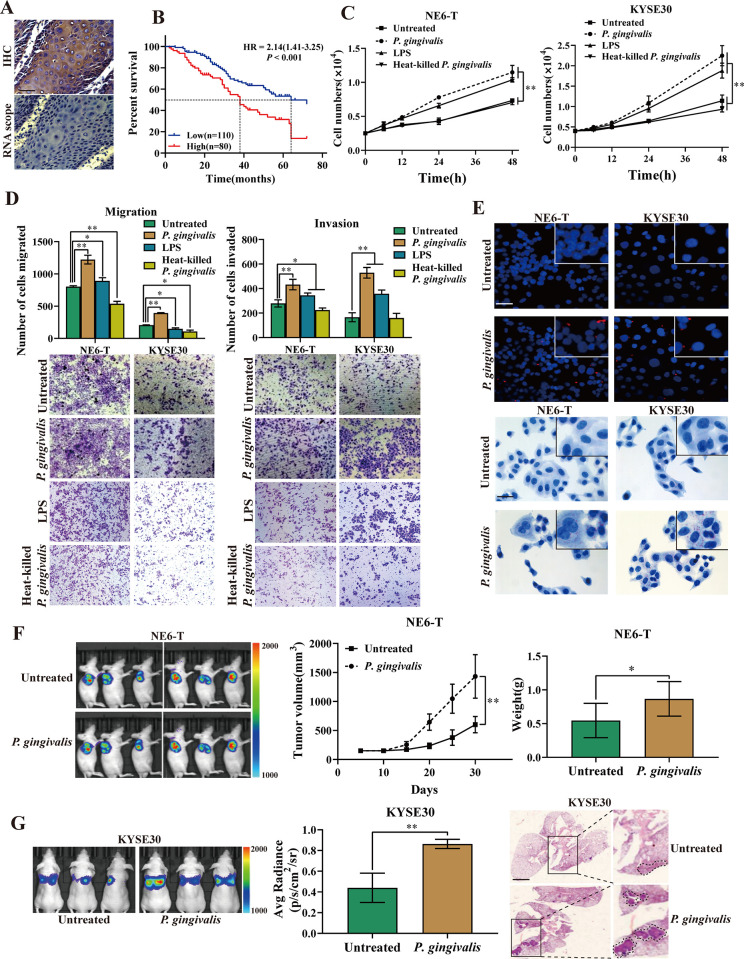
P. gingivalis predicts poor clinical outcome and promotes ESCC cell aggressive progression.(A) Representative images of IHC and RNAscope of P. gingivalis in ESCC. Scale bars, 50 μm. (B) Kaplan–Meier survival curves for 190 patients with ESCC were compared between patients with high and low amounts of P. gingivalis. (C) The cell growth rates of NE6-T and KYSE30 cells in vitro treated with P. gingivalis, LPS or heat-killed P. gingivalis or untreated for indicated times were evaluated by an MTT assay. **P < 0.01 by Student t test. (D) The haptotactic migration assay and matrigel chemoinvasion assay of NE6-T and KYSE30 cells treated with P. gingivalis or LPS, heat-killed P. gingivalis or untreated. **P < 0.01 by Student t test. (E) Accumulation of P. gingivalis in NE6-T and KYSE30 cells after 24 h of P. gingivalis infection were shown by confocal immunofluorescence microscopy (upper panel) and RNAscope assay (lower panel). Scale bar, 50 μm. (F) The left panel shows representative fluorescent images of GFP signals captured from subcutaneous tumors. The middle and right panels show the tumor growth curve (**P < 0.01 by one-way ANOVA and Bonferroni multiple comparison test) and tumor weight (*P < 0.05 by one-way ANOVA). (G) Left panel, representative bioluminescent images of photon flux show the lung metastasis. Middle panel, bioluminescent quantification of metastatic cells in lung (**P < 0.01, Mann–Whitney U test). Results represent means ± SD. Right panel, representative HE staining shows ESCC cell lung metastasis. ANOVA, analysis of variance; ESCC, esophageal squamous cell carcinoma; GFP, green fluorescent protein; HE, hematoxylin–eosin; IHC, immunohistochemistry; LPS, Lipopolysaccharide; MTT, 3-[4,5-dimethyl-2-thiazolyl]-2,5-diphenyl-2H-tetrazolium bromide; RNAscope, RNA in situ hybridization.